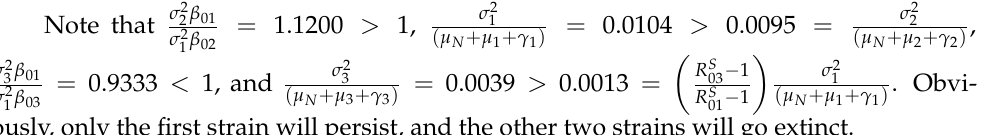
Figure 5. The simulated numbers of infected individuals under the conditions of the disease persis- tence.